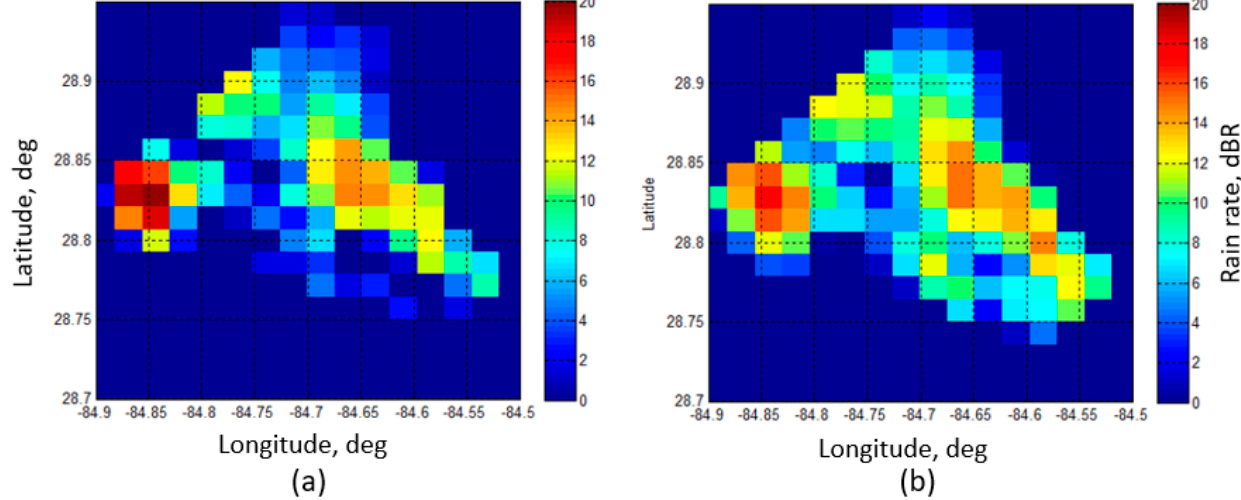
Figure 9. Rain rate CAPPIs at 4 km altitude gridded in 2 km cubes and in units of dBR for ( a ) HIWRAP and ( b ) NEXRAD.